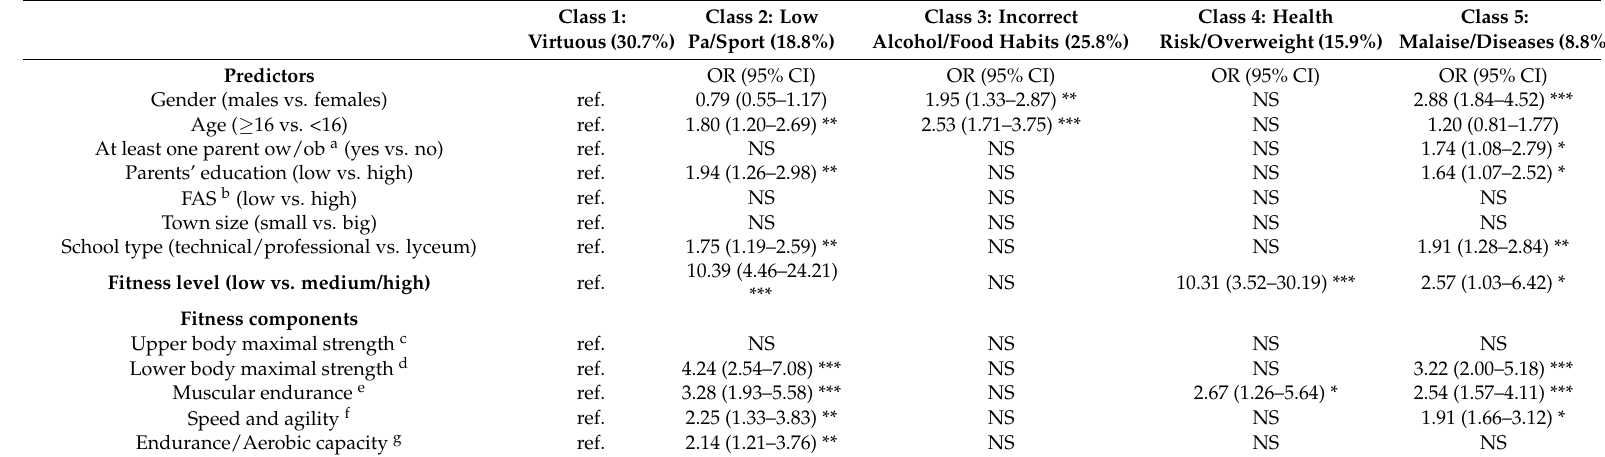
Table 4. Associations between latent classes and possible predictors of class